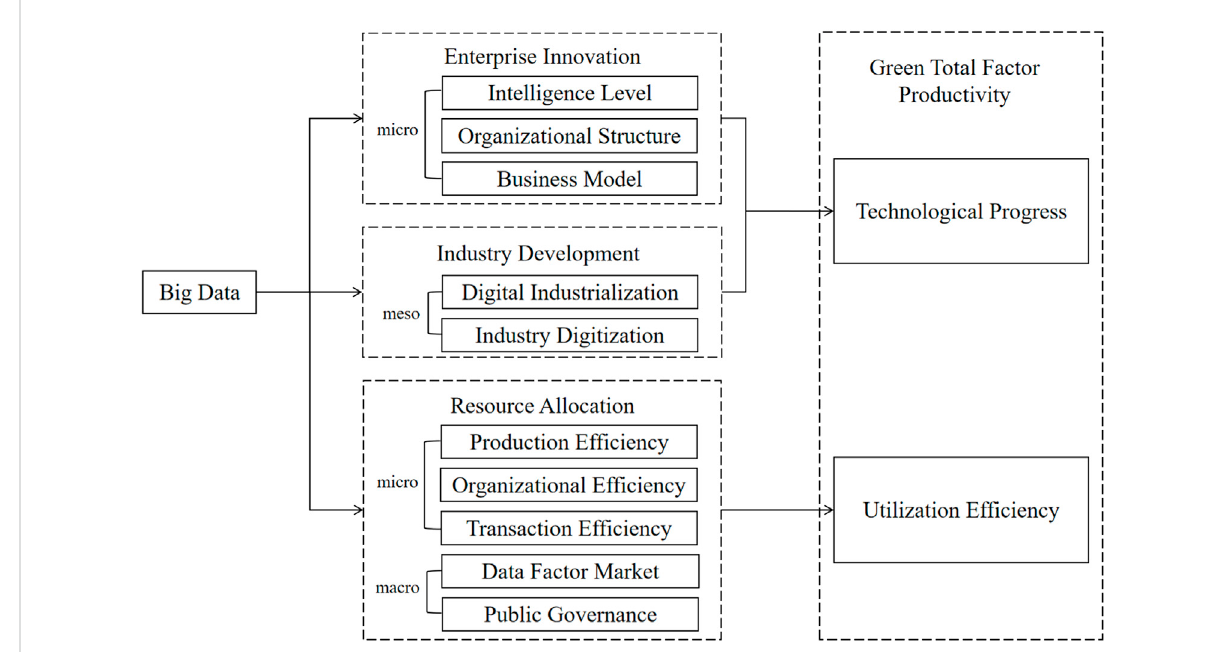
FIGURE 1 Mechanism of big Data ’ s impact on green economic